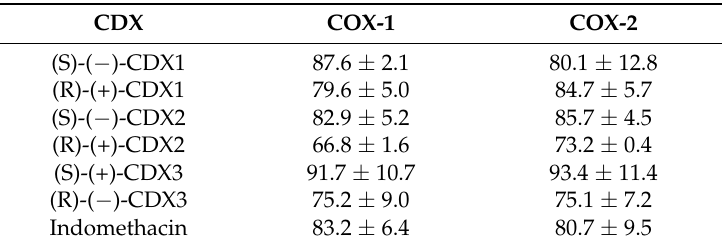
Table 1. Inhibitory effects of CDXs on COX-1 and